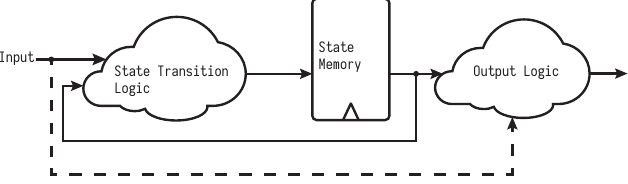
Figure 1: Block diagram of a hardware FSM (dashed line in the case of a Mealy